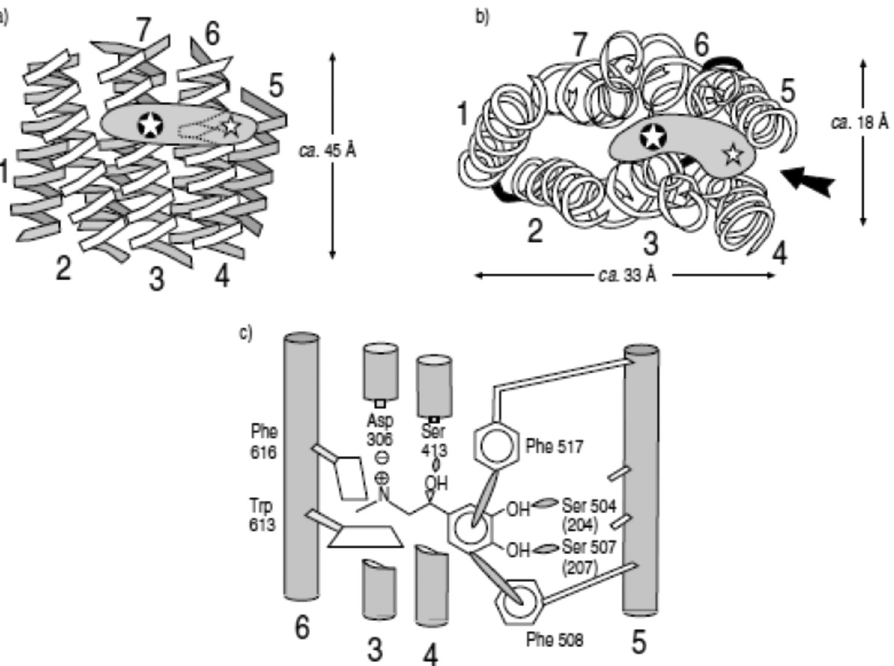
Figure 3: Schematic diagram of the β - adrenoreceptor and its binding domain for agonist ( ☆ ) and antagonist ( ✪ ) . Helices are individually numbered, and the approximate dimension of the receptor is marked in Angstroms ( Å ) . ( a ) ( Side - view ) It shows a cut - away view of the seven - transmembrane α - helices of the β - adrenoreceptor seen from the plane of the membrane lipid bilayer. ( b ) ( Top view ) It shows the same beta - adrenoreceptor viewed from the extracellular space. ( c ) It shows an expanded detail of the ligand - binding site for agonists formed by helices 3, 4, 5, and 6, during binding of adrenaline. Reproduced with the permission of the © ERS 2020: European